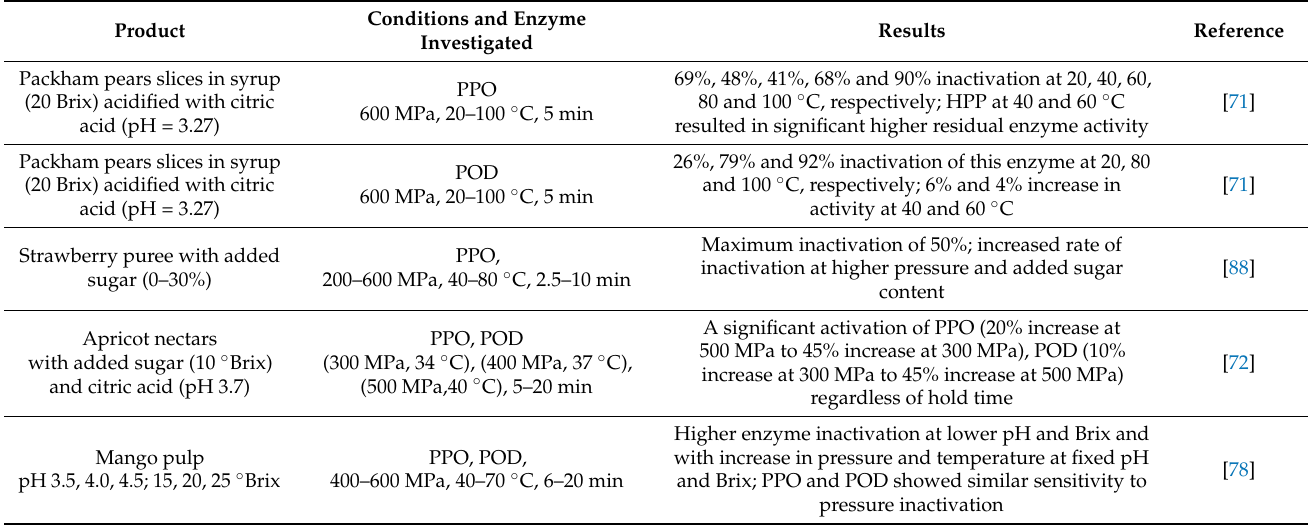
Table 4. Summary of relevant studies on the effect of HPP on color degrading